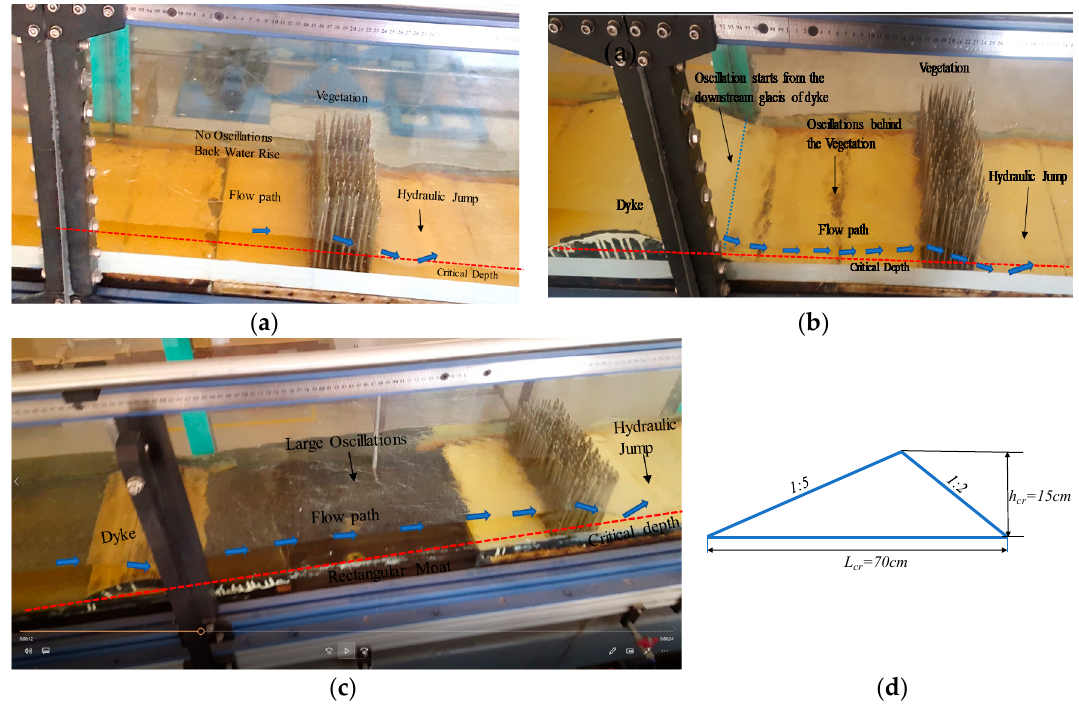
Figure 7. Experimental photographs: ( a ) only vegetation (OV) model ( b ) dike and vegetation (DV) model and ( c ) dike, moat and vegetation (DMV) model, ( d ) crump weir model for delay time analysis.